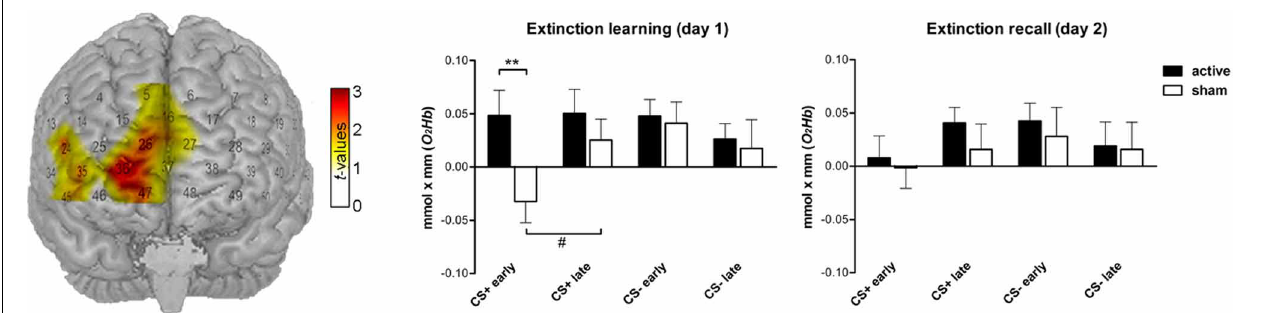
FIGURE 7 | Functional NIRS results (O 2 Hb) during both extinction phases ( n = 25). Left : T-map superimposed on a standard brain. During the early extinction learning the active group showed a higher signal for CS + than the sham group in a cluster of 10 probeset channels covering the medial prefrontal cortex. The bar charts in the middle and on the